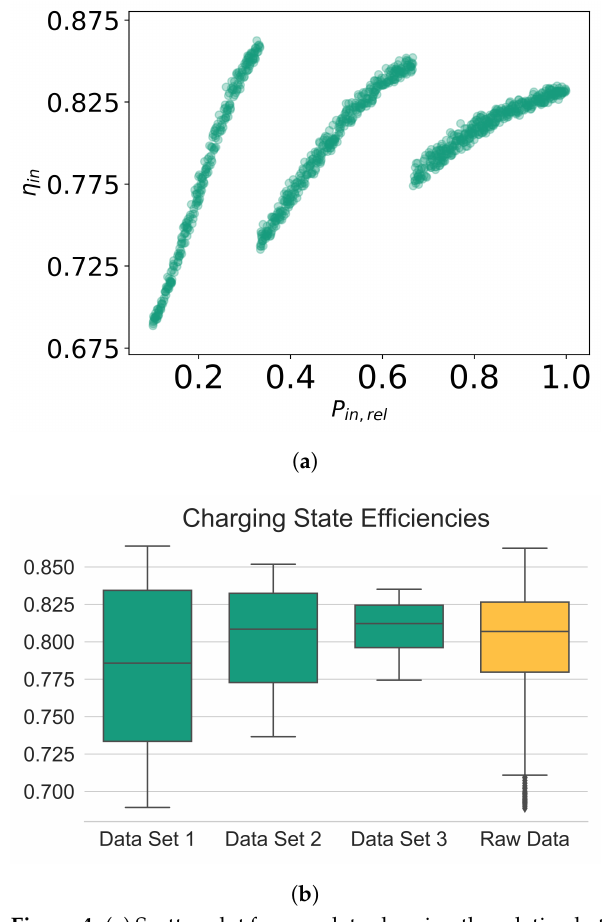
Figure 4. ( a ) Scatter plot for raw data showing the relation between P in , rel and charging state efficiency η in , and ( b ) box plot showing the IQRs (boxes and lines) and classified outliers (black diamonds) for η in on the partitioned data sets (green) and the raw data